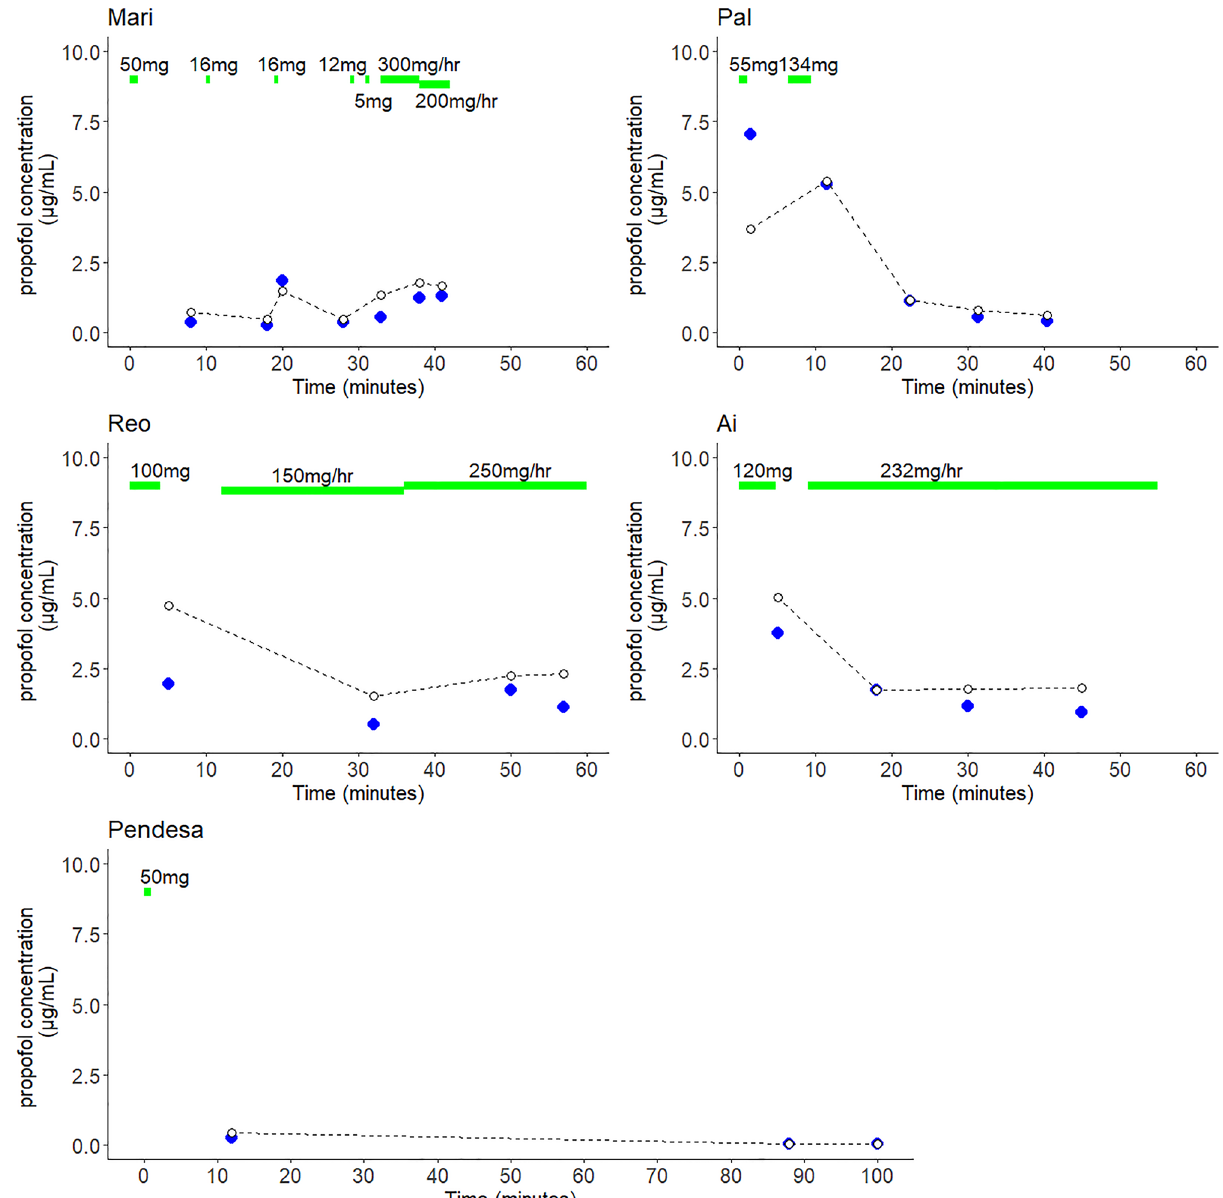
Figure 1. Time course of Cps following propofol bolus and/or infusion in five chimpanzees. Blue circles represent measured Cps and white circles and dotted lines indicate predicted Cps using Marsh model. Green bars indicate amount of propofol